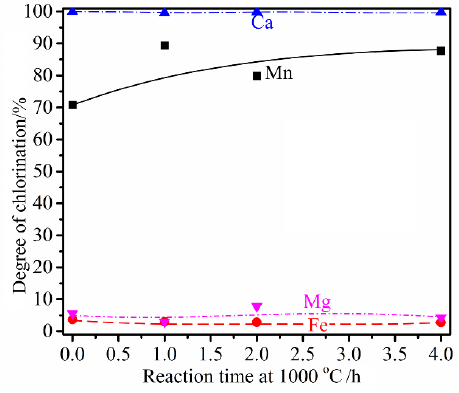
Figure 14. Degree of chlorination vs. reaction time at 1000 °C with the addition of 20 wt% CaCl 2 and 40 wt% MgCl 2 .